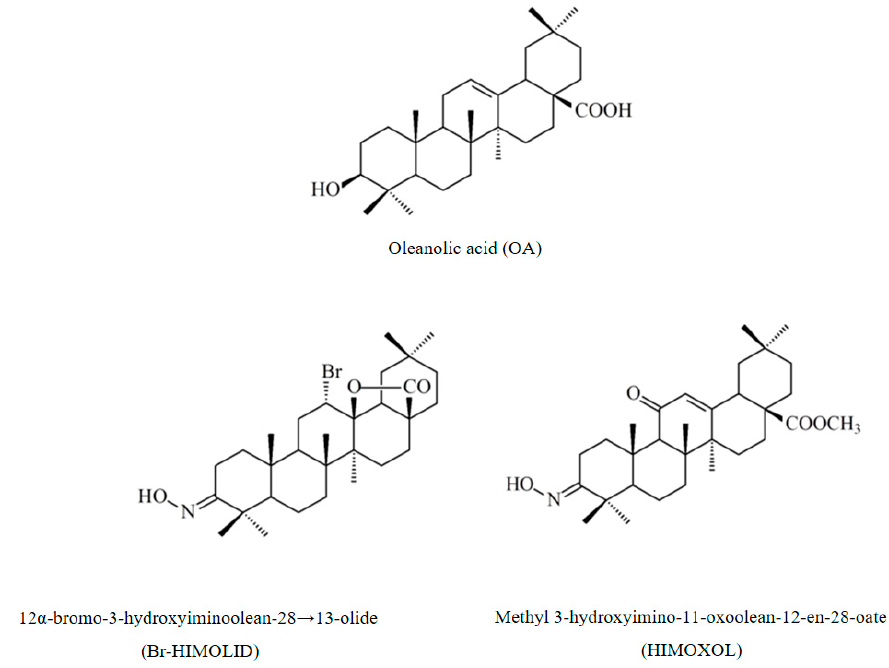
Figure 8. Structure of oleanolic acid (OA) and its derivatives that were studied in breast cancer cells. The cell culture media, RPMI 1640, and fetal bovine serum were purchased from Biochrome (PAA, Pashing, Austria). The RPMI 1640 culture medium without phenol red was purchased from Gibco (Thermo Fisher Scientific, MA, USA). The MTT, fulvestrant, rapamycin, and camptothecin were obtained from Sigma-Aldrich (Sigma-Aldrich, Munich, Germany). Gefitinib was obtained from Cell Signaling Technology (Danvers, MA,